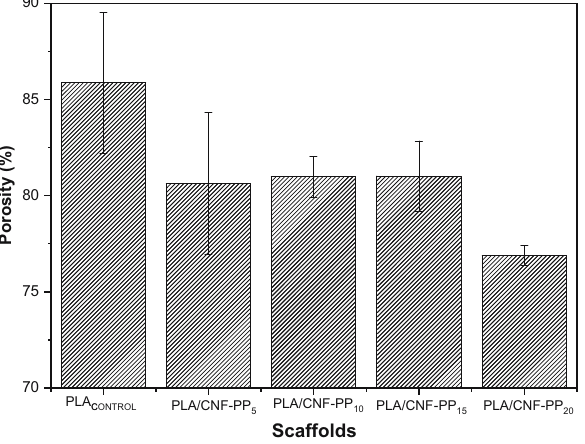
Figure 2: Porosity measurements of PLA sca ff olds with di ff erent